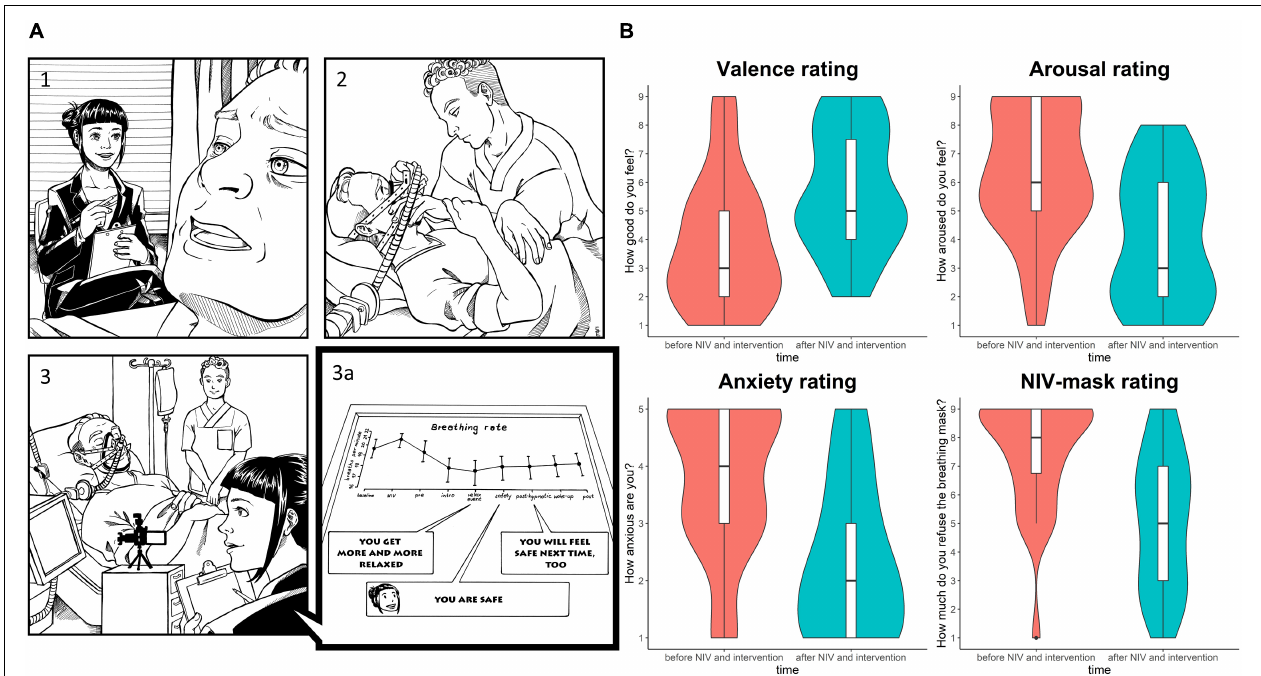
FIGURE 2 | (A) Illustration of the procedure of the intensive care study. The psychologist asked the patient about his current emotional state. Then, a member of the medical staff puts on the NIV breathing mask. During the ventilation session, the psychologist accompanies the patient with therapeutic suggestions of safety. The vital sign monitor shows that breathing rate was reduced during safe place suggestions. (B) Results of ratings before and after NIV sessions accompanied with safe place suggestions showing better mood, less arousal and anxiety, and a more positive evaluation of the NIV mask after the